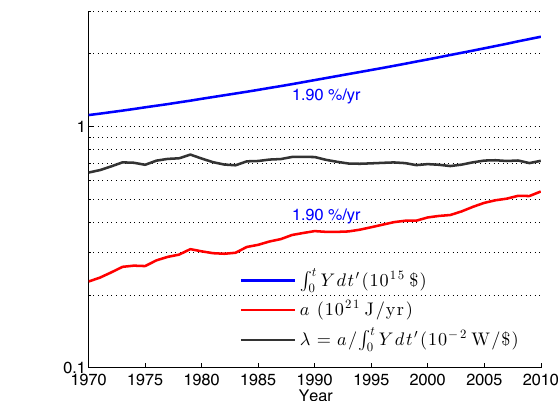
Figure 3. Rates of global energy consumption a , global wealth t R C = Y ( t (cid:48) )d t (cid:48) , and the ratio λ = a/C since 1970. The average rates 0 of growth η for a and C in percent per year are shown for compar- ison. The average value of λ is 7.1 ± 0.1mW per year 2005 USD. Note the y axis is a logarithmic